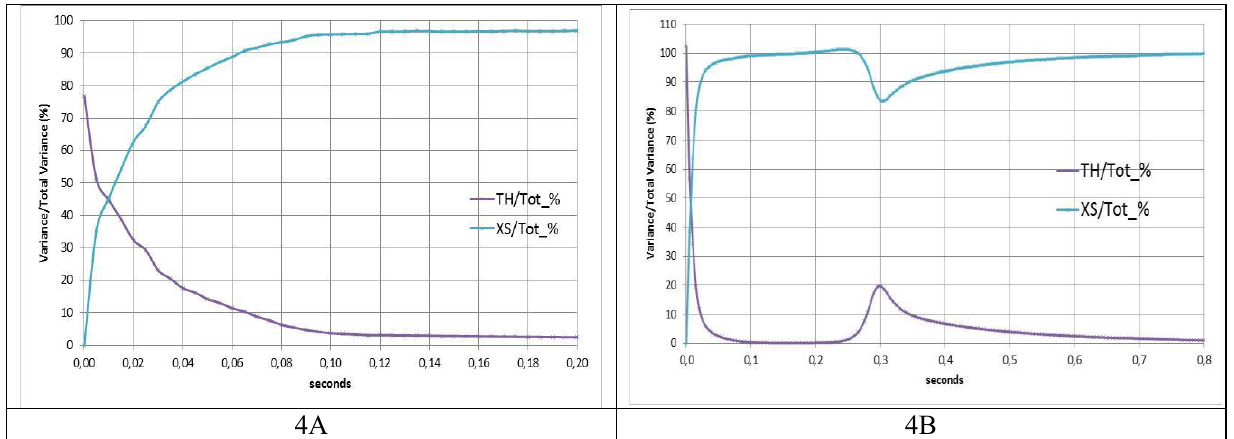
Figure 4: Partial Variances. 4A: 0.78$ reactivity, 4B 1.14$ reactivity (after 0.16s and 0.8s the curves are